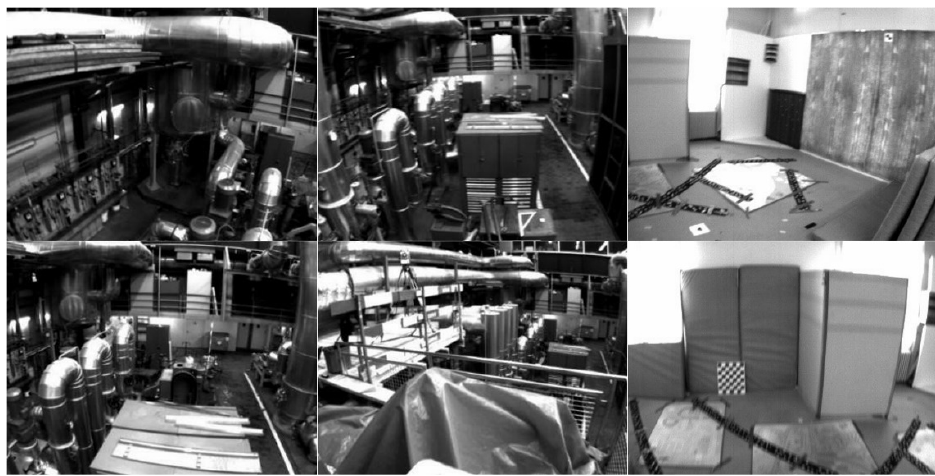
Figure 11. Partial dataset image.